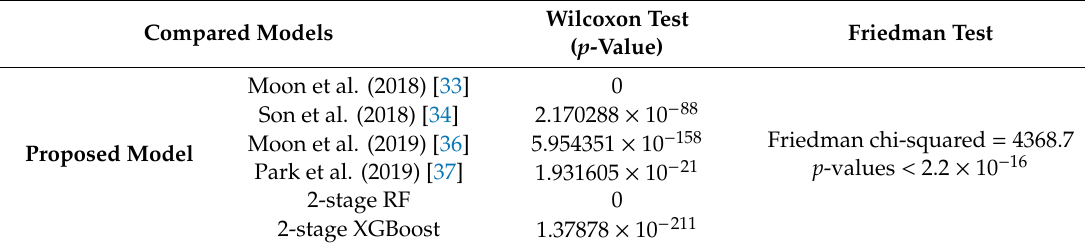
Table 12. Results of Wilcoxon test and Friedman test.